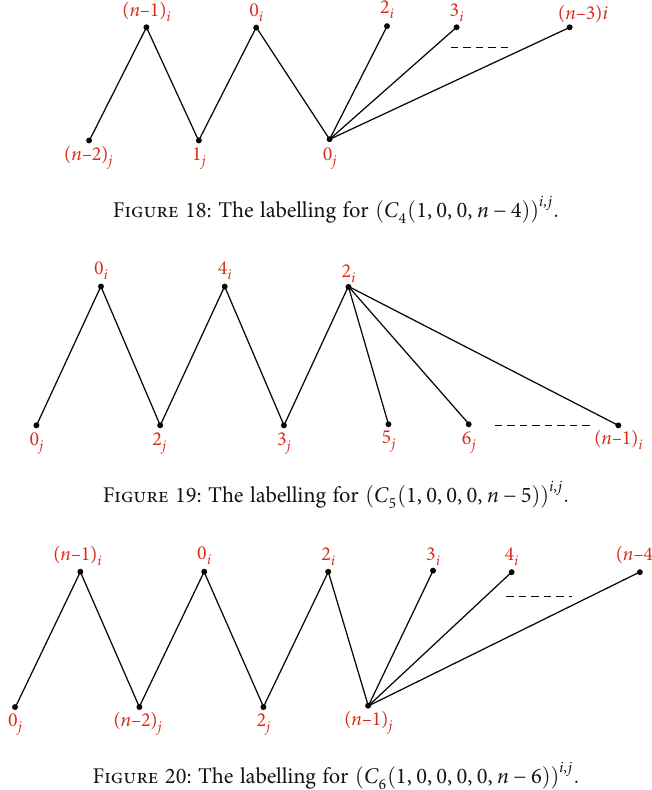
Figure 20: The labelling for ð C